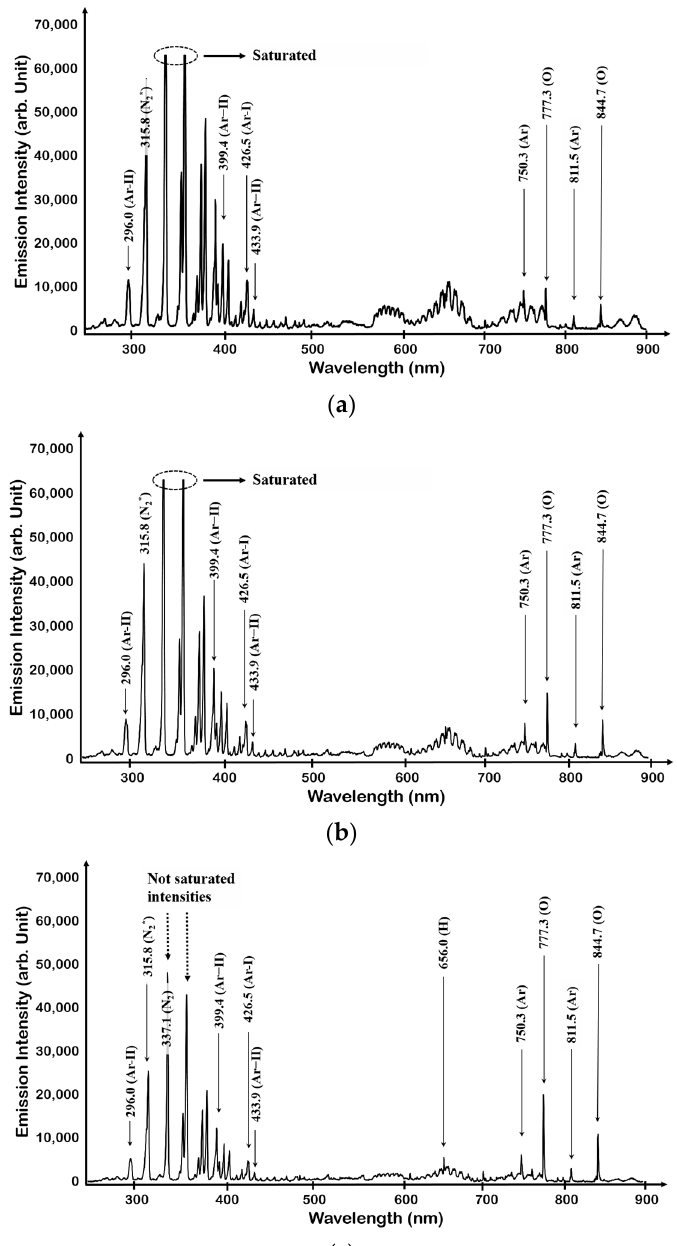
Figure 4. OES spectrum of N 2 + O 2 plasma: ( a ) the case of N 2 + O 2 (80:20), ( b ) the case of N 2 + O 2 (50:50), and ( c ) the case of N 2 + O 2 (20:80).